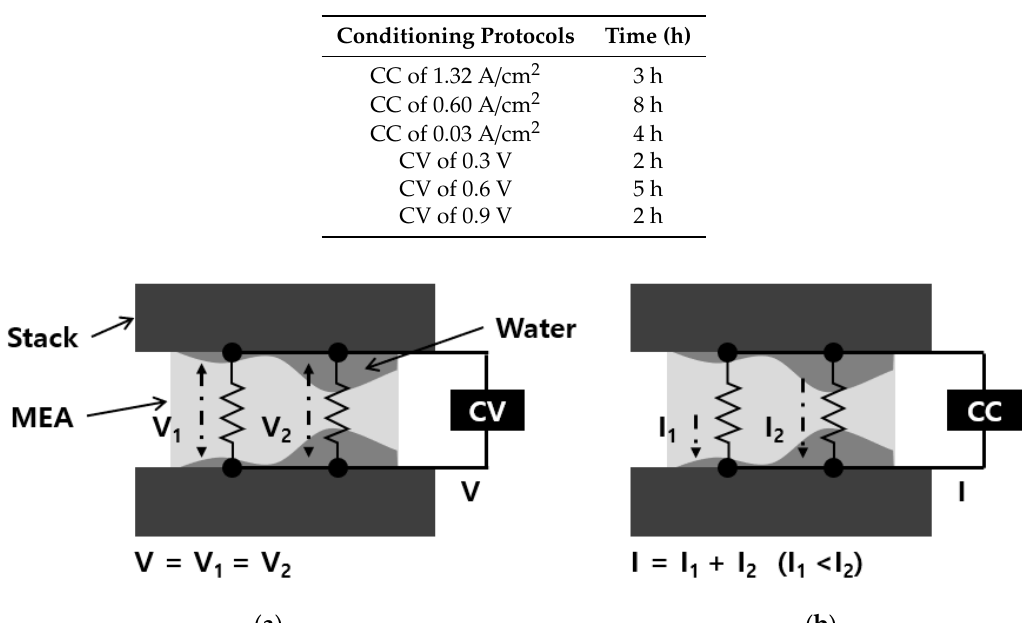
Table 2. Time required for complete conditioning.